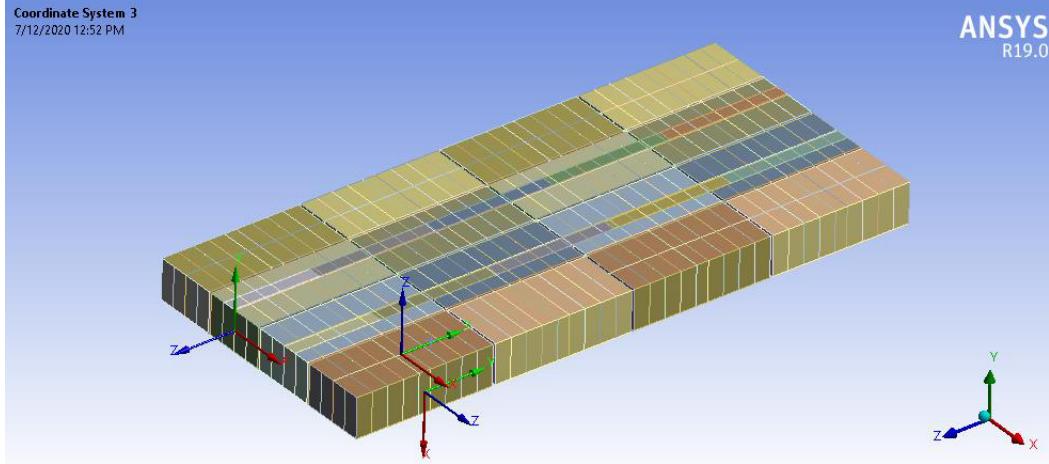
Figure 12. Coordinate systems. Table 2. The material properties and strength parameters of epoxy carbon unidirectional (UD) and woven (230 GPa).